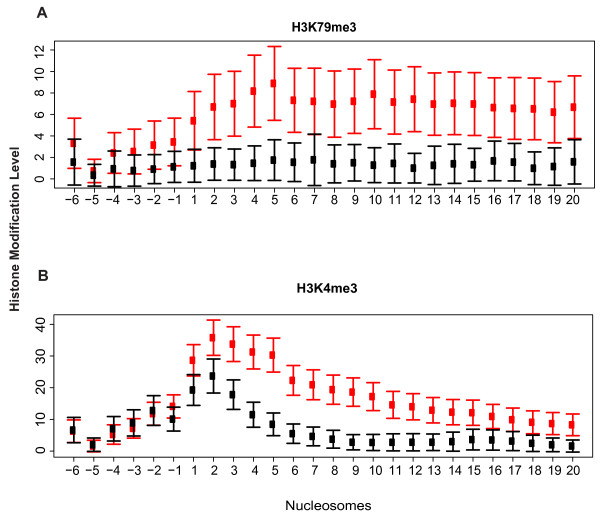
The distribution of HMV levels in proximal promoter regions. The dots and bars give the average and standard deviation of HMV levels in each nucleosome, respectively. Data for CD4SE genes are shown in red, and data for HK genes are shown in black. The x-axis shows the index of the nucleosomes. The nucleosomes upstream of the TSS are assigned as minus (-) and the nucleosomes downstream of the TSS are assigned as plus (+). A) H3K79me3 and B) H3K4me3 are the most predictive HMV types selected for nonCpG-related genes from Set I and Set II, respectively (see Additional file 3).